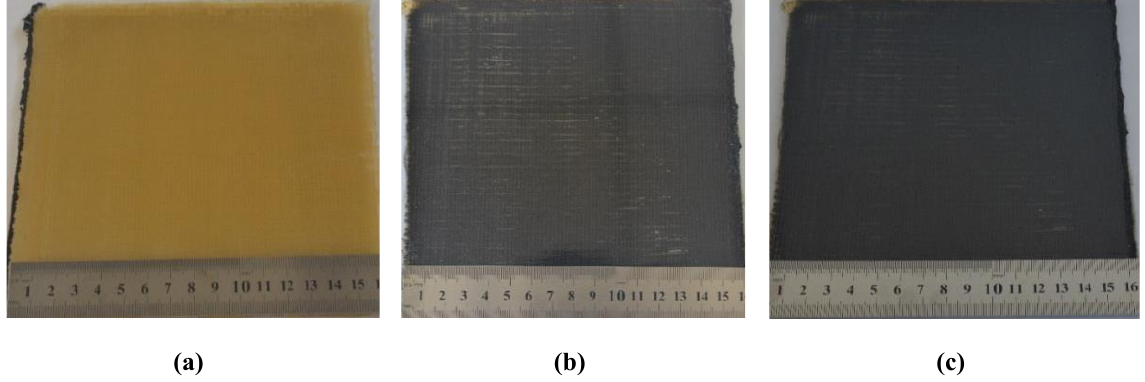
Figure 4: The photographs of the prepared 3D MWK composite: (a) desized composite; (b) D 400 -GO-grafted composite; (c) GO-grafted